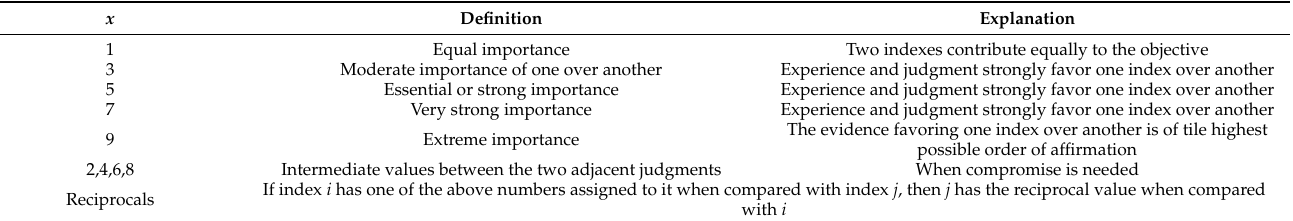
Table 2. The fundamental scale for x 1